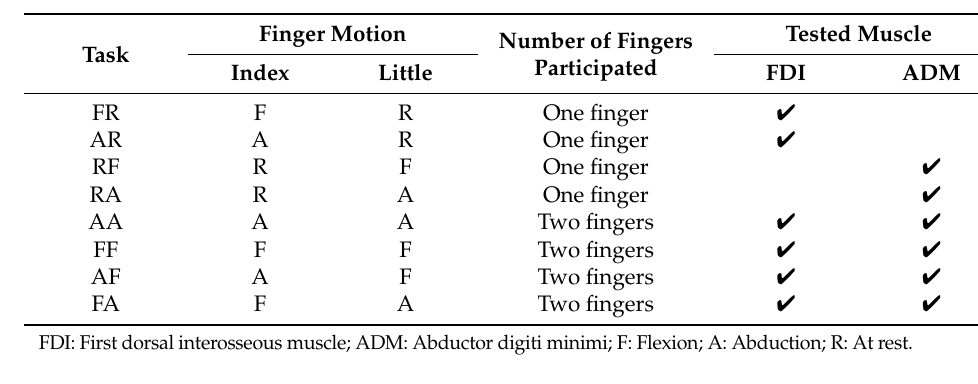
Table 1. Motor tasks.